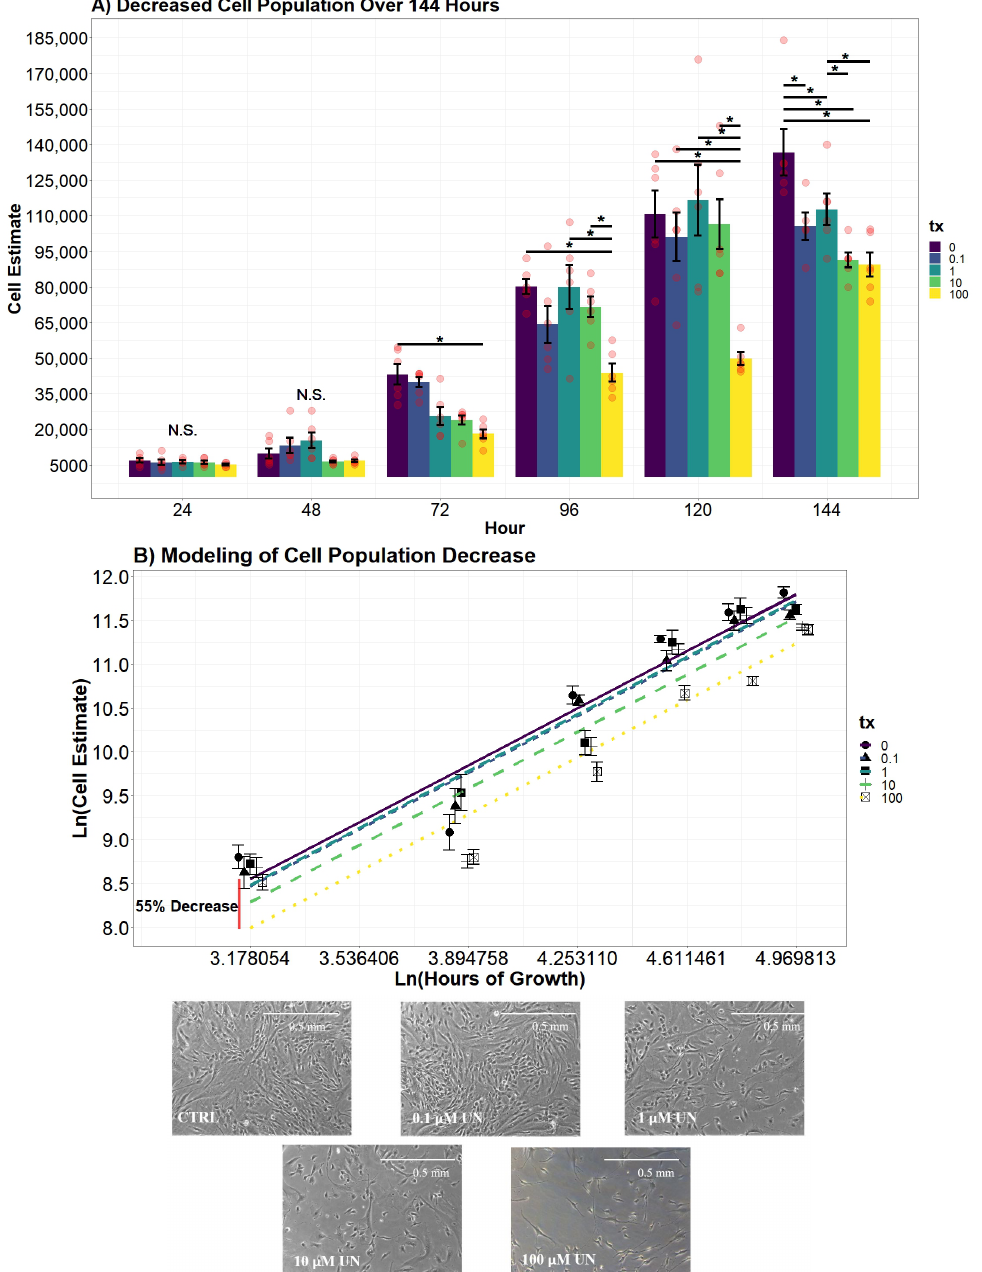
Figure 4. ( A ) Fibroblast cell population reduced when exposed to increasing levels of UN over 144 hour growth curve (n = 6 for each level of UN). Cell counts were identically and independently collected. Contrasts were performed by a Tukey pairwise t -test across significant variables from an interaction two-way ANOVA. Significance bars, marked with “ * ”, refer to significant Tukey pairwise t -tests between the conditions at the beginning and the end of the bar. Days where no significant differences were observed are labeled with N.S. ( B ) Modeled regression lines of ln(cell estimate) growth over 144 h (R 2 = 0.8788). Colors of least squares (LS) lines differentiate UN levels. LS best fit lines represent predicted Ln(cell adj estimate) based on UN concentration and Ln(hour). Points represent mean cell estimate for each group ±StrErr. Red vertical line represents the largest percent cell estimate difference observed between 100 µ M and control. Images were taken using light microscopy and used to illustrate differences in cell population after 72 h of exposure (100 × total